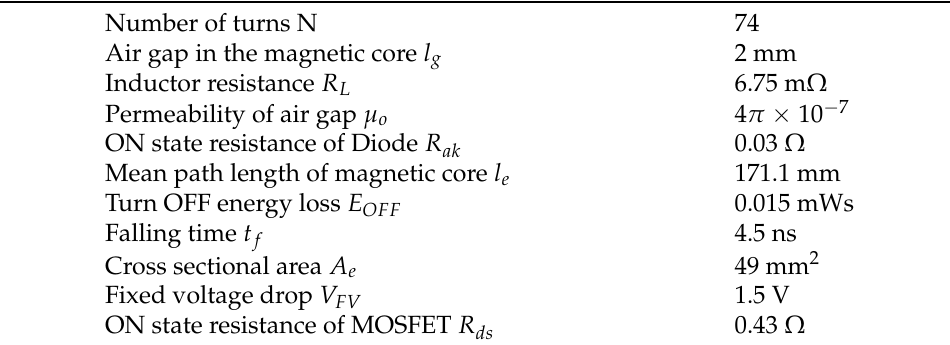
Table 4. Power loss calculating parameters.